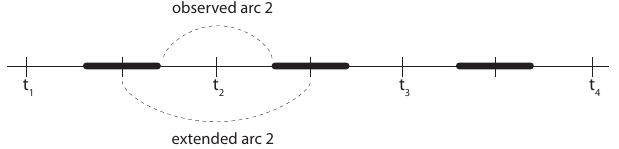
Figure 3. Schematic representation of observed and extended arc. The times t i ( i = 1,..,4) are the central epoch of each arc; the black bars correspond to dark intervals, without tracking from Earth. See the text for more